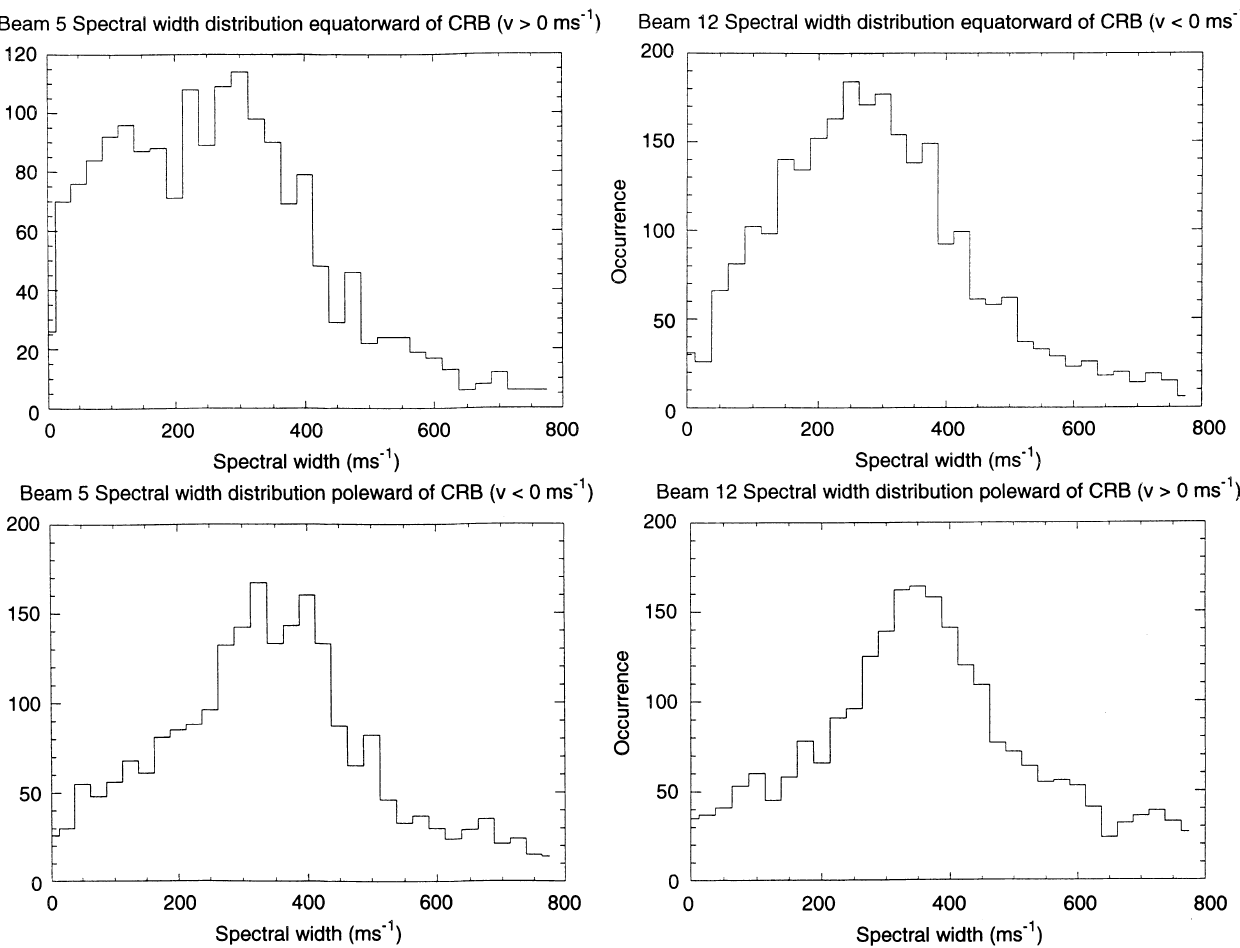
Fig. 6 The spectral width distribution of the positive and negative line-of-sight velocities for beams 5 and 12 between 0500 and 0800 UT. In general the negative (positive) velocities are detected poleward (equatorward) of the CRB in beam 5 and are oppositely directed in